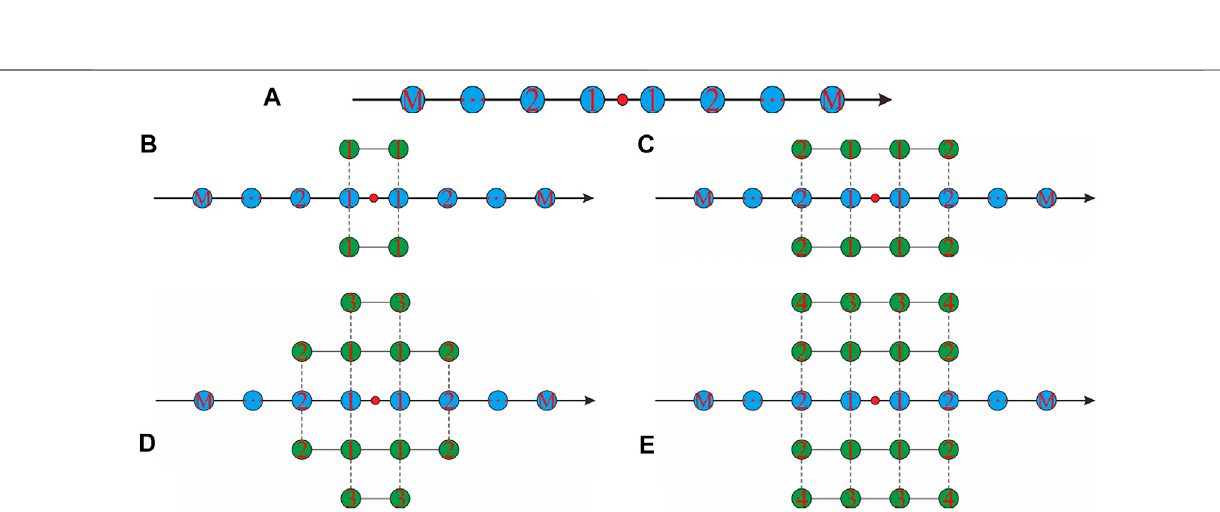
Frontiers in Earth Science |